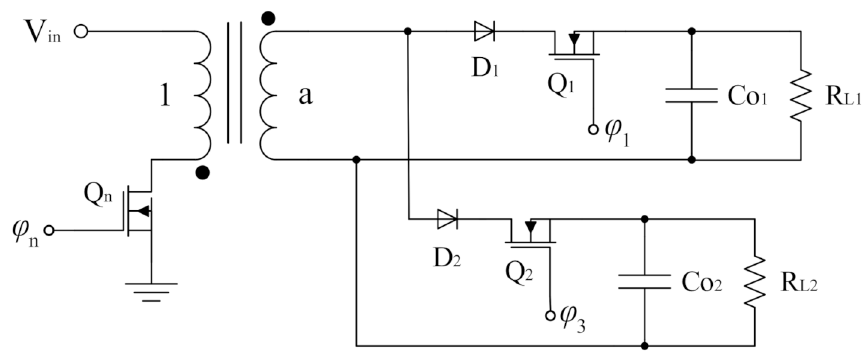
Figure 3. Topology of the proposed SIMO power supply without series